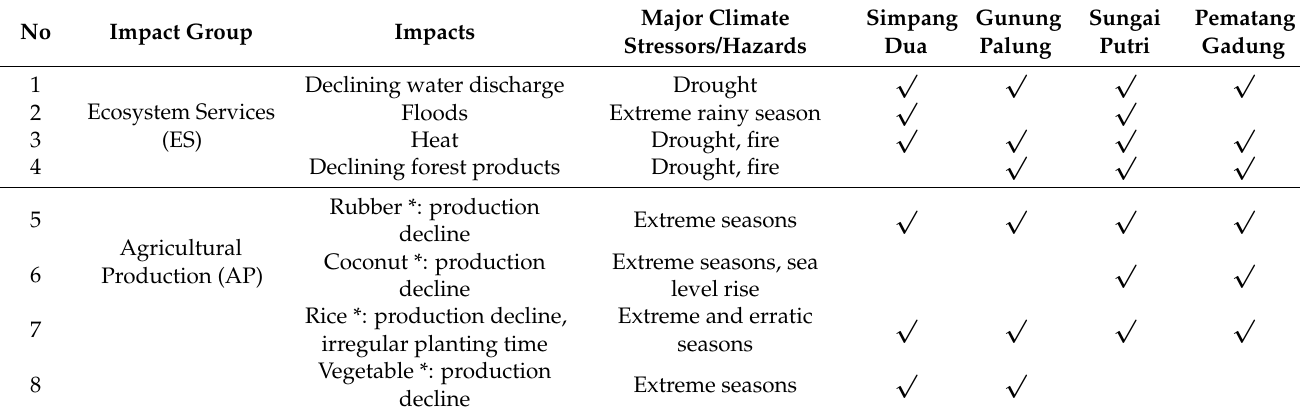
Table 3. Impacts under ES and AP impact groups identified in four landscapes.